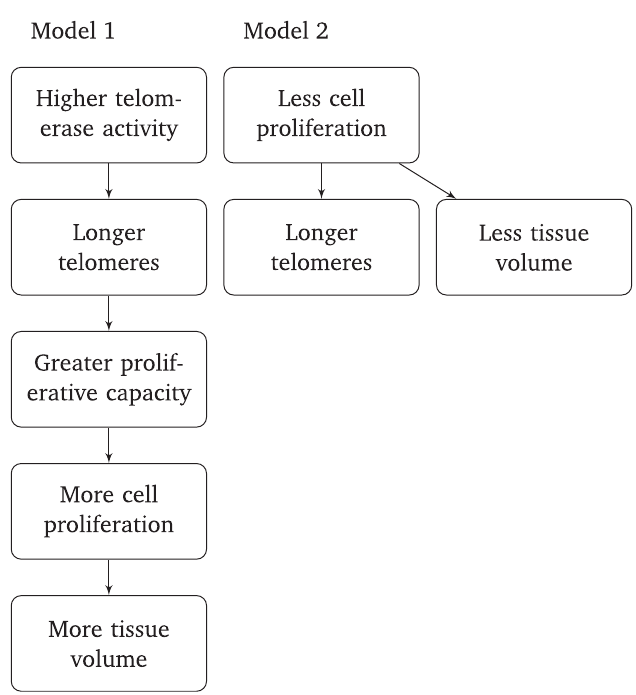
Figure 4. Two models proposed in earlier literature for relationships between telomere length and hippocampus